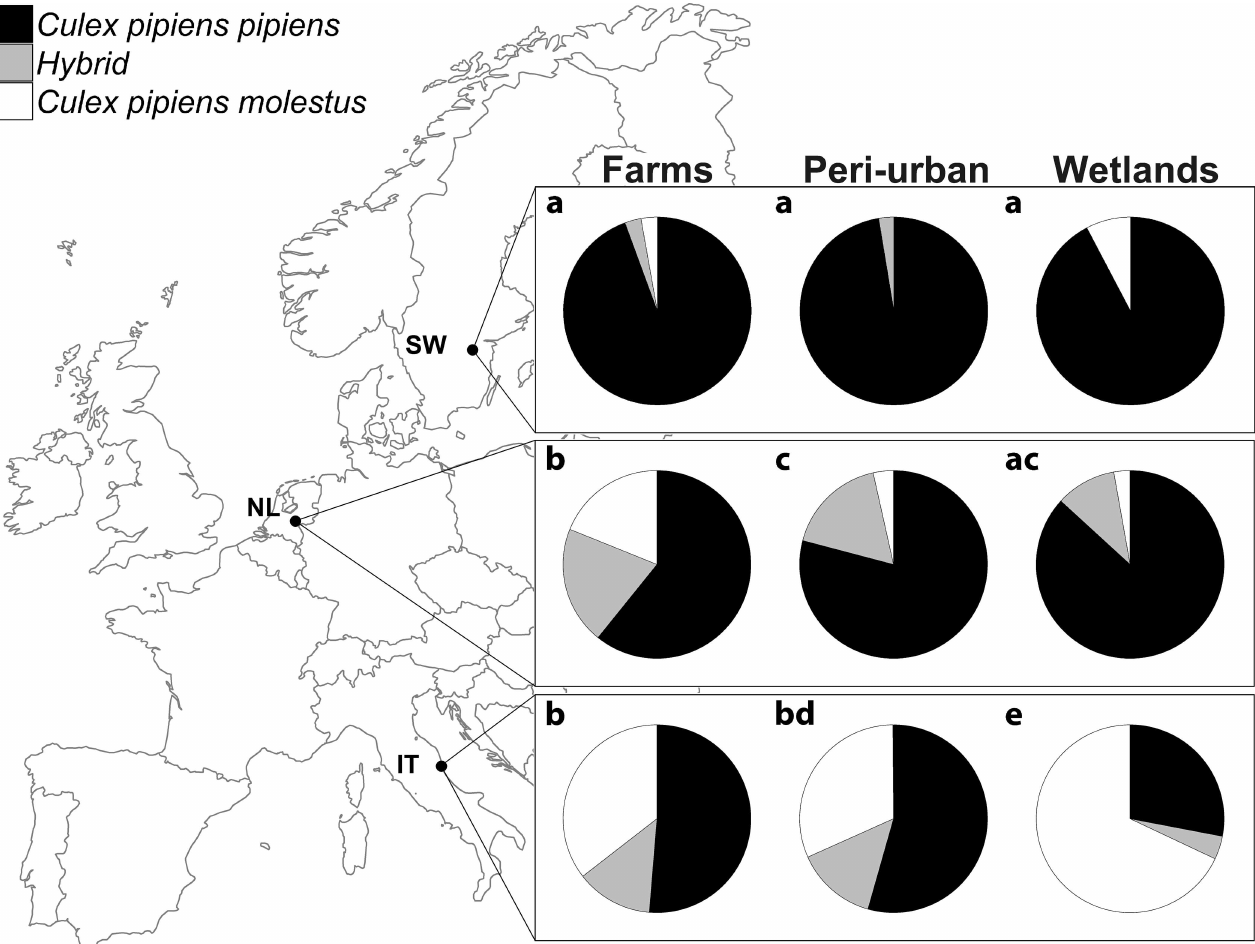
Fig 2. Within-effect of habitat within each of the three countries on the ratio of Culex pipiens biotypes and their hybrids (rows), and within-effect of country within each habitat type (columns). The sample size for each pie chart ranges betweenn = 26–115.Letters display significantdifferences betweenratios shown in rows and columns, at a significancelevel of p < 0.05. SW = Sweden,NL = The Netherlands, and IT =